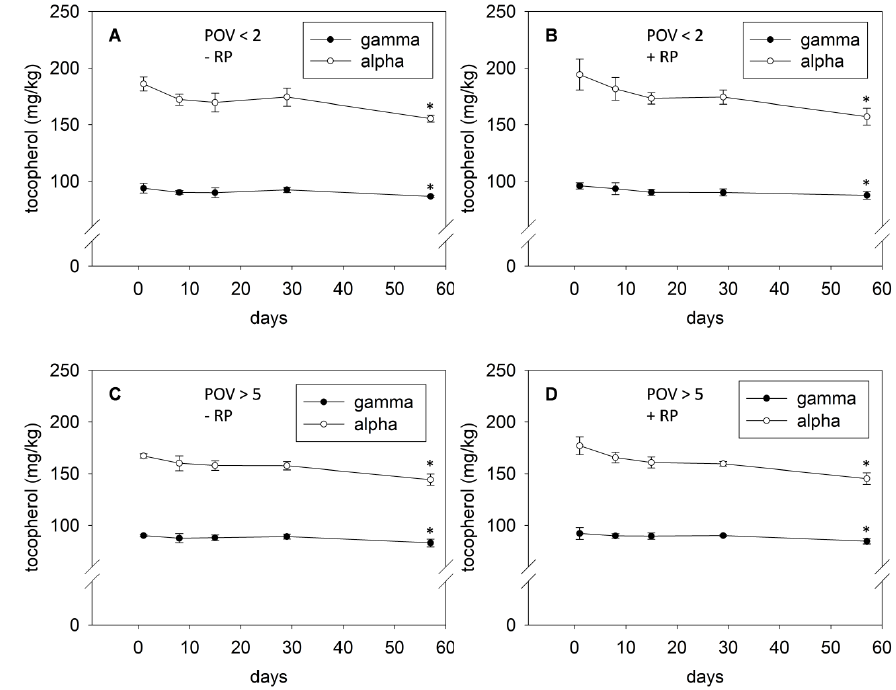
Figure 3. Decrease of α - and γ -tocopherol in mildly ( A , B ) and highly ( C , D ) oxidized palm oil either fortified ( B , D ) or not ( A , C ) with retinyl palmitate (RP) after household-representative storage for up to 57 days. Data are expressed as mean ± SD ( n = 4). Asterisks (*) indicate a statistically significant difference vs. day 1 ( p < 0.05).